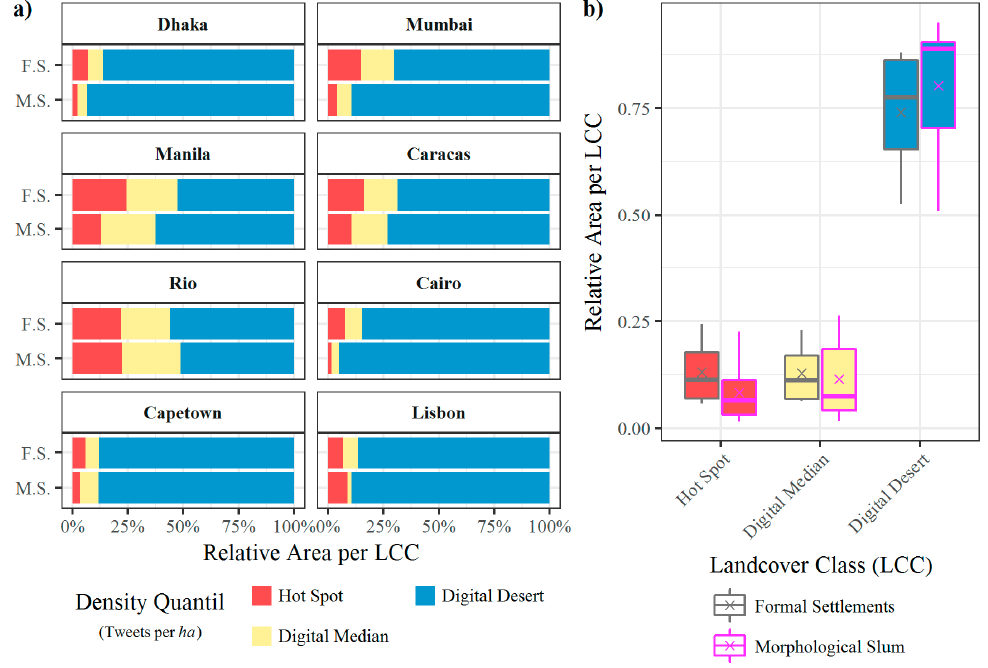
Figure 5. Zonal statistics of tweet density classes per city and land cover class: ( a ) Bar charts showing the fraction of areas covered by the tweet density classes. As size of cities and especially morphological slums vary (see Table 1), the areas are normalized to 100%, thus each bar cumulates to a total area covered by the respective land cover class. The abbreviation F.S. represents formal settlements and M.S. represents morphological slums; ( b ) Boxplots summarizing the zonal statistics by digital activity class. The mean is additionally displayed with a cross.